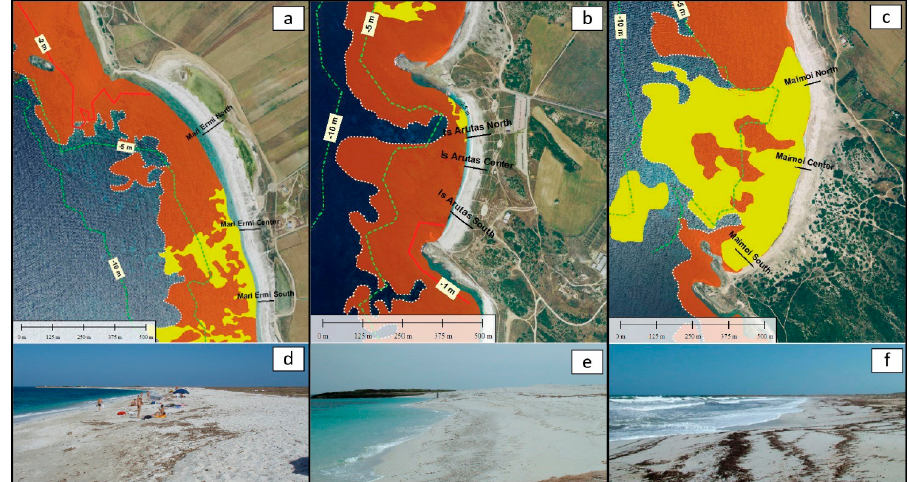
Figure 2. ( a ) The main features of Mari Ermi beach and the location of the profile; ( b ) the main features of Is Arutas beach and the location of the profile; ( c ) the main features of Maimoi beach and the location of the profile; ( d ) an overview of Mari Ermi; ( e ) an overview of Is Arutas; and ( f ) an overview of Maimoi.